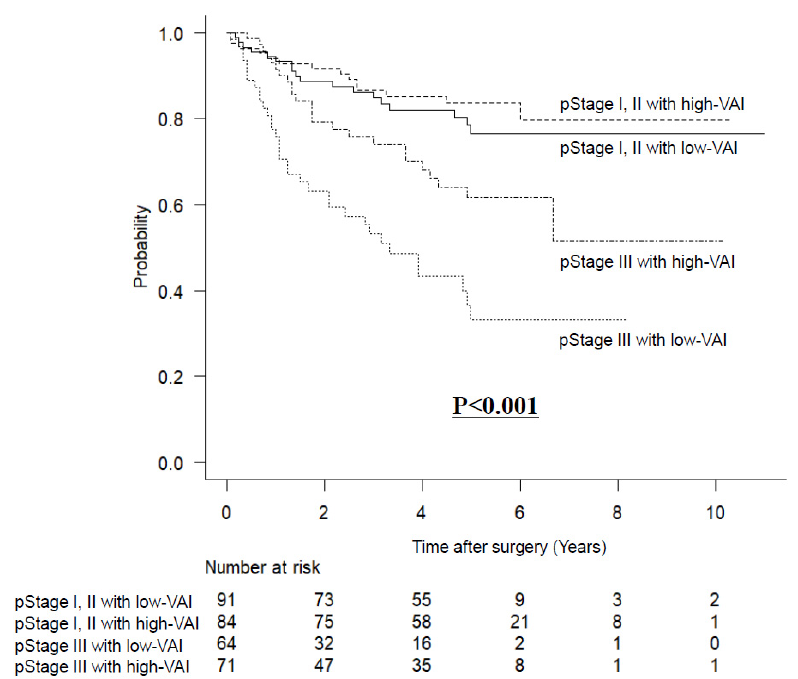
Figure 4. Kaplan–Meier survival curves for overall survival stratified by visceral adipose tissue and pathological stage after matching.